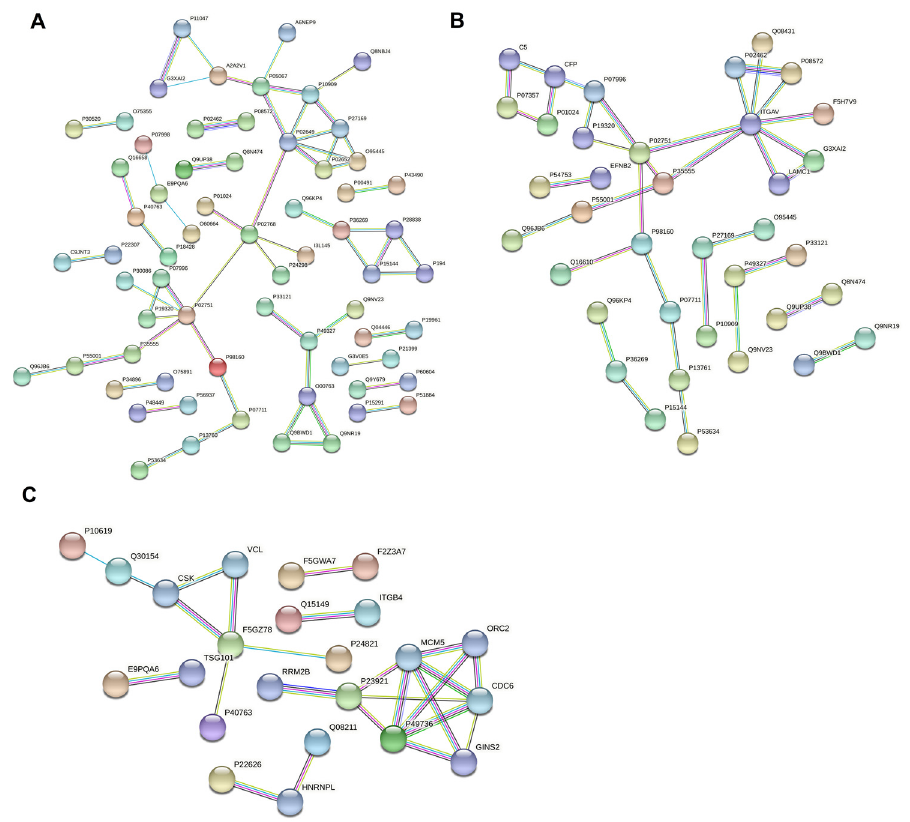
Figure 6. Protein–protein interaction network analysis of differentially expressed proteins in C vs. M ( A ), C vs. T ( B ), and M vs. T ( C ). Each node represents a protein, and each edge represents the interaction between proteins.